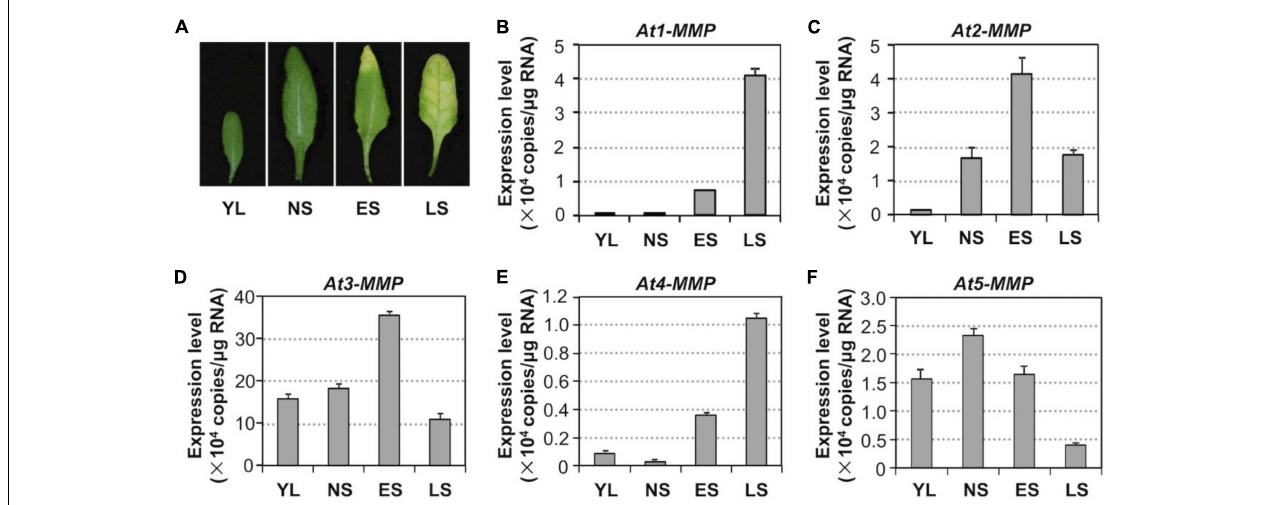
FIGURE 5 | Activation of MMP expression during leaf senescence in Arabidopsis. (A) Leaf senescence in wild type plants at four different developmental stages. YL, young leaves; NS, fully expanded no senescence mature leaves; ES, early senescence leaves, with < 25% leaf yellowing; LS, lately senescence leaves, with > 50% leaf yellowing. (B–F) Transcript levels of MMPs increase in an age-dependent manner. Samples were collected from leaves shown in (A) at the indicated developmental stages. Gene expression was quantified by RT-qPCR and calculated as copy numbers per µ g of total RNA. Values are means ± SD, n =